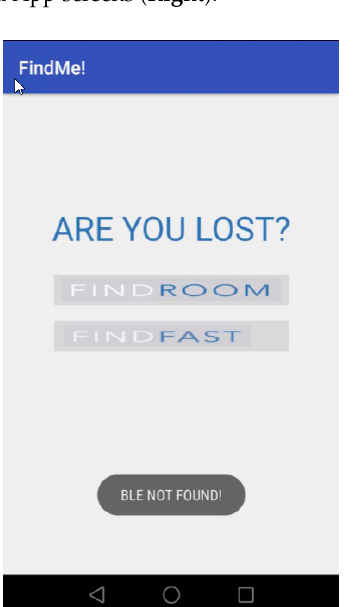
Figure 16. Test 2—Origin and destination ( Left ), paths using the stairs with beacons intersection signal ( Center ) and App screens ( Right ).